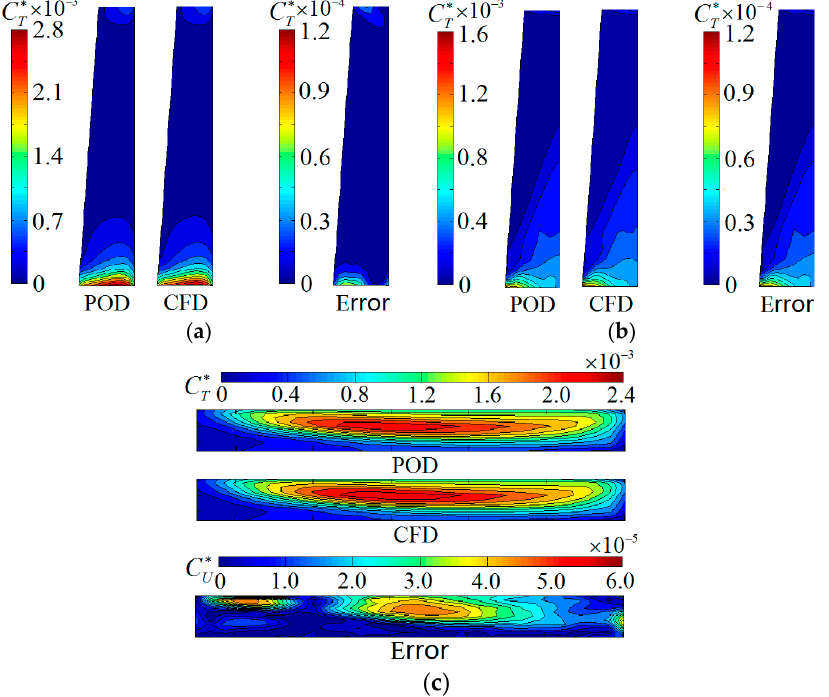
Figure 15. CFD calculation, POD reconstruction, and their error of turbulent kinetic energy fluctuation intensity on the blade surface and circumferential surface of impeller outlet. ( a ) Pressure surface; ( b ) Suction surface; ( c ) Circumferential surface of impeller outlet.